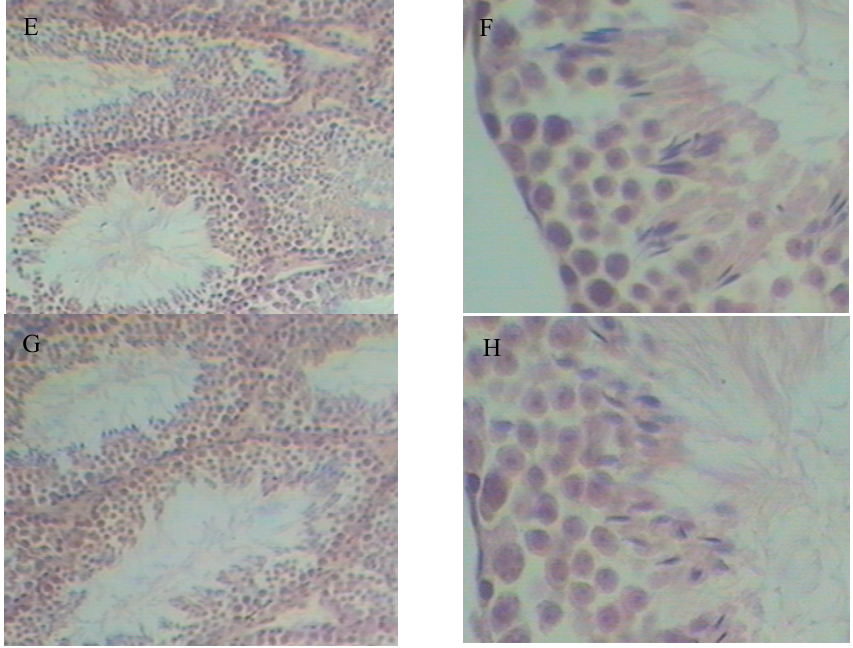
Figure 3. Role of sulforaphane (SFN) in Cd-induced histopathology (original magnification A , C , E , G 100×; B , D , F , H 400×). ( A , B ) Control group; ( C , D ) CdCl 2 group (2.3 mg/kg); ( E , F ) SFN group (10 mg/kg); ( G , H ) CdCl 2 (2.3 mg/kg) + SFN (10 mg/kg) group (thin arrow: Leydig cells; thick arrow: seminiferous tubule; open thin arrow: mature sperm; open thick arrow: sperm cell).